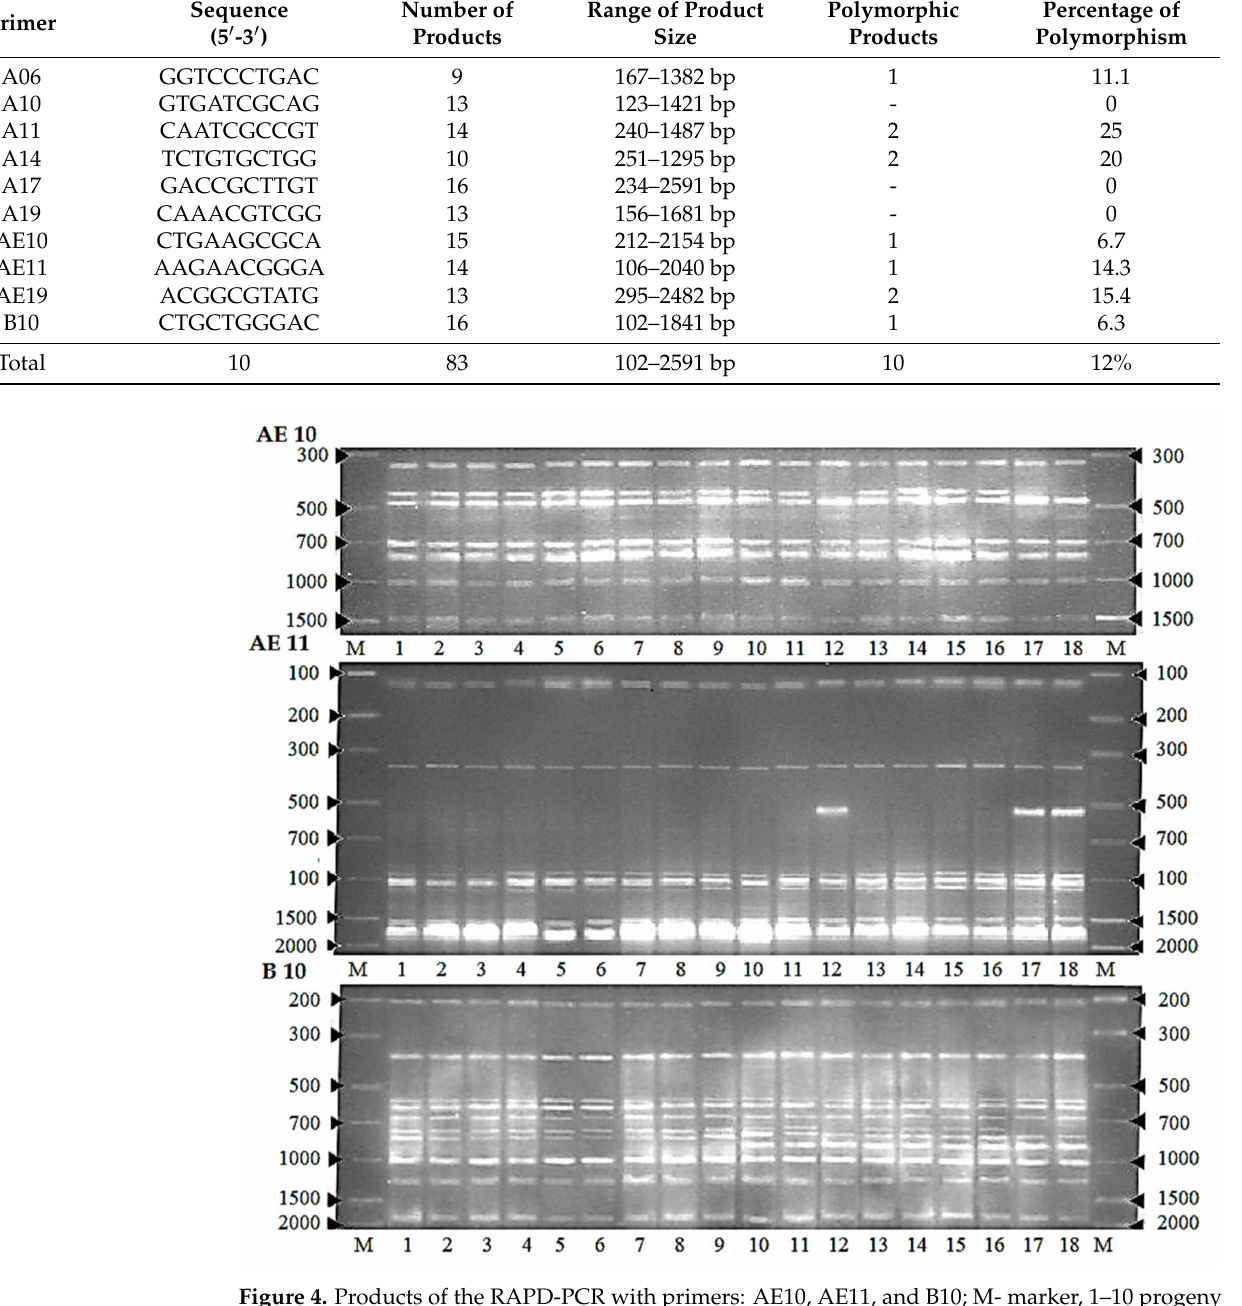
Figure 4. Products of the RAPD-PCR with primers: AE10, AE11, and B10; M- marker, 1–10 progeny of anther-derived diploid of ( C. annuum L. ATZ × C. annuum L. Corno di toro)F 2 , 11–18 progeny of anther-derived haploid of ( C. annuum L. ATZ × C. annuum L. Corno di toro)F 2 . The ISSR technique was used for the genetic analysis of the second generation of the diploid plants derived from the andro-haploid regenerant (Table 3). As a result of the analyses carried out with 16 ISSR primers, the total number of 97 monomorphic products were obtained, and their sizes ranged from 123 to 1832 bp. The number of bands generated per primer varied from four (I 11) to nine (I 9). All the amplified products showed the genetic homogeneity of the second generation of the diploid plants derived from the andro-haploid